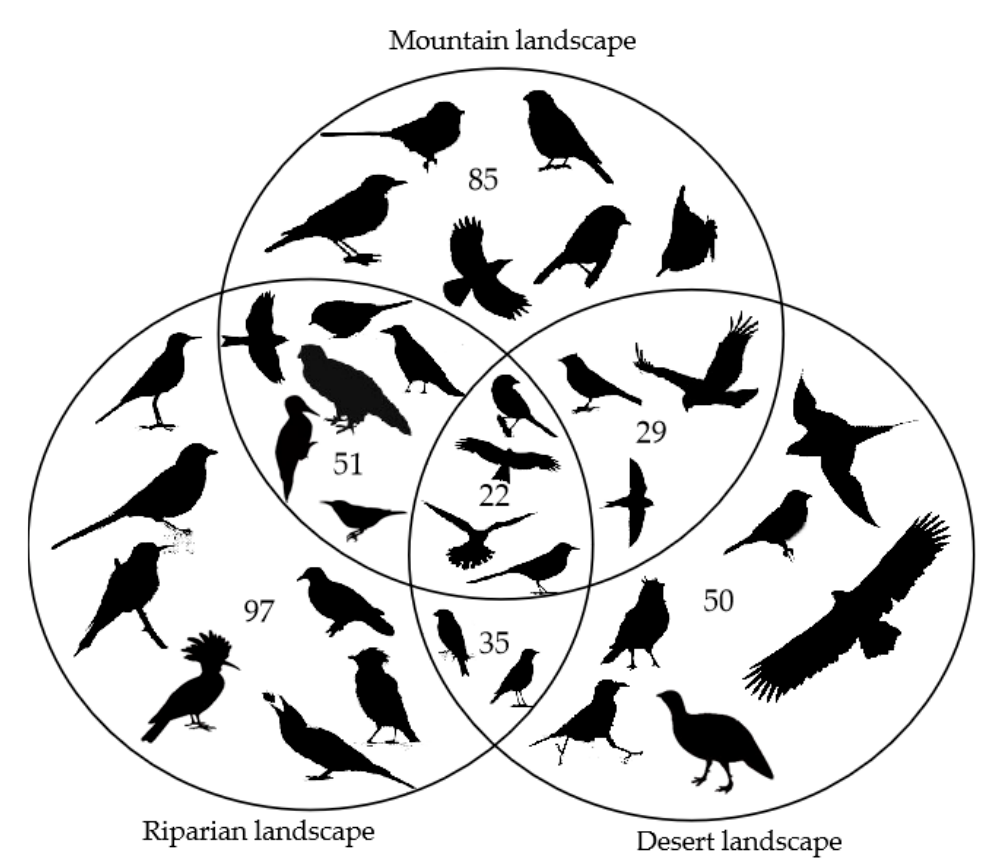
Figure 2. Number of bird species detected in the mountain, riparian and desert landscapes, shared by every pair of landscapes and by all three landscapes. Table 1. Elevational range, number of transect lines (localities), number of species detected in more than two transect lines, pairwise dissimilarity values for Sørensen’s (beta.sor), Simpson’s (beta.sim), nestedness component (beta.nes), and the ratio of nestedness component to Sørensen’s dissimilarity (beta.ratio) in metacommunity A (localities in the whole study area), metacommunity M (localities in the mountain landscape), metacommunity R (localities in the riparian landscape) and meta- community D (localities in the desert landscape). The Stand Error values of dissimilarity indices were calculated by locality pair compared.